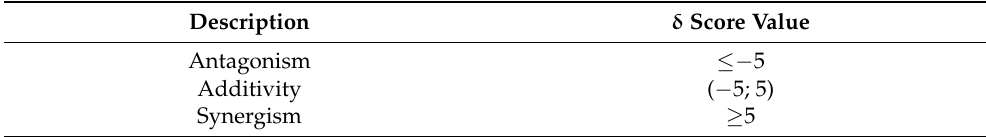
Table 1. Drug interaction classification based on delta score (Synergyfinder package).